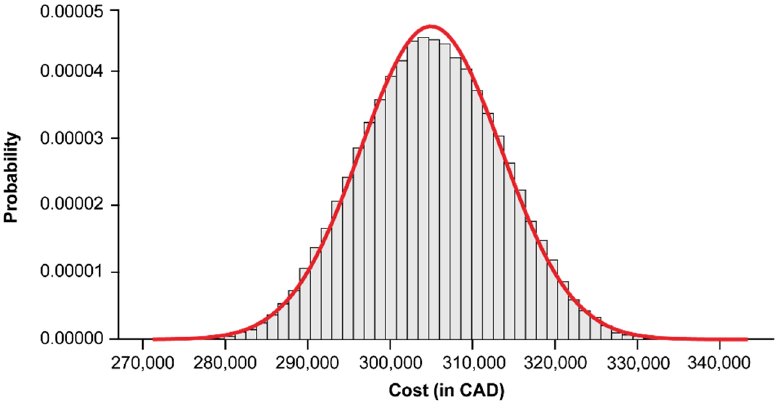
Figure 12. Predicted cumulative cost of reporting as a distribution.